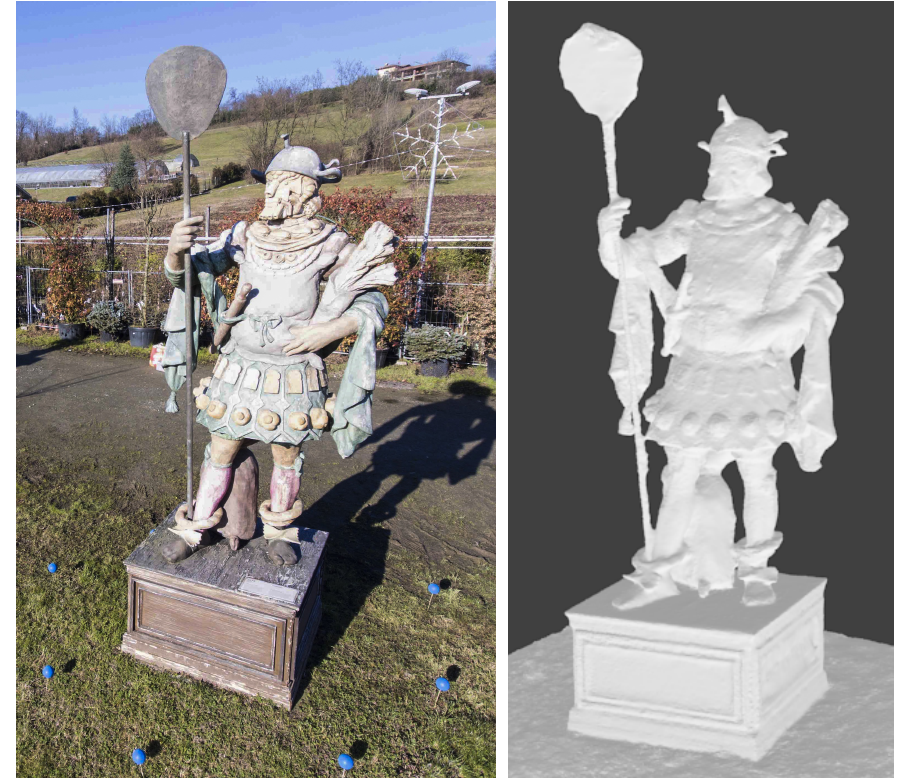
Figure 8. ( Left ) one of the acquired images from a sculpture by D. Ferretti (Expo 2015, Milan, Italy). Due to its complex shape, this represented a particularly difficult subject to reconstruct with good accuracy. ( Right ) a view of the reconstructed 3D model of the